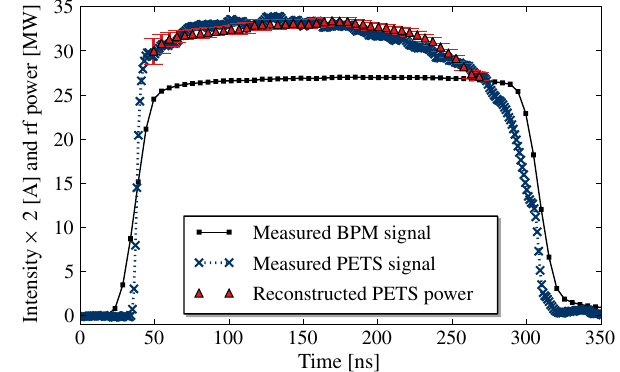
FIG. 3. One of the installed PETS tanks, which keeps the structure in a vacuum. In the front, one can see a waveguide arm, where the rf power is coupled out,measured, and dissipated in a load.